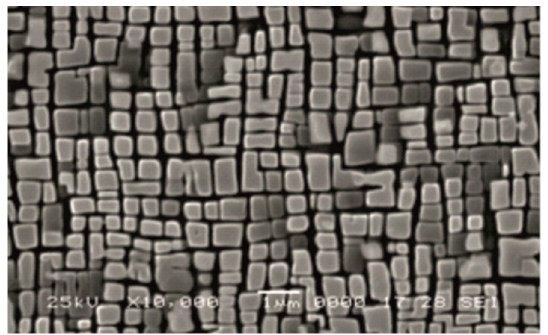
Figure 2. Typical coherent γ‐γ ’ microstructure in single crystals of Ni ‐ 16W ‐ 5Ta HRAs (mass. %); light rectangles are particles of the strengthening γ ’ ‐ phase. Reprinted with permission from Ref. [13]. Copyright 2008,